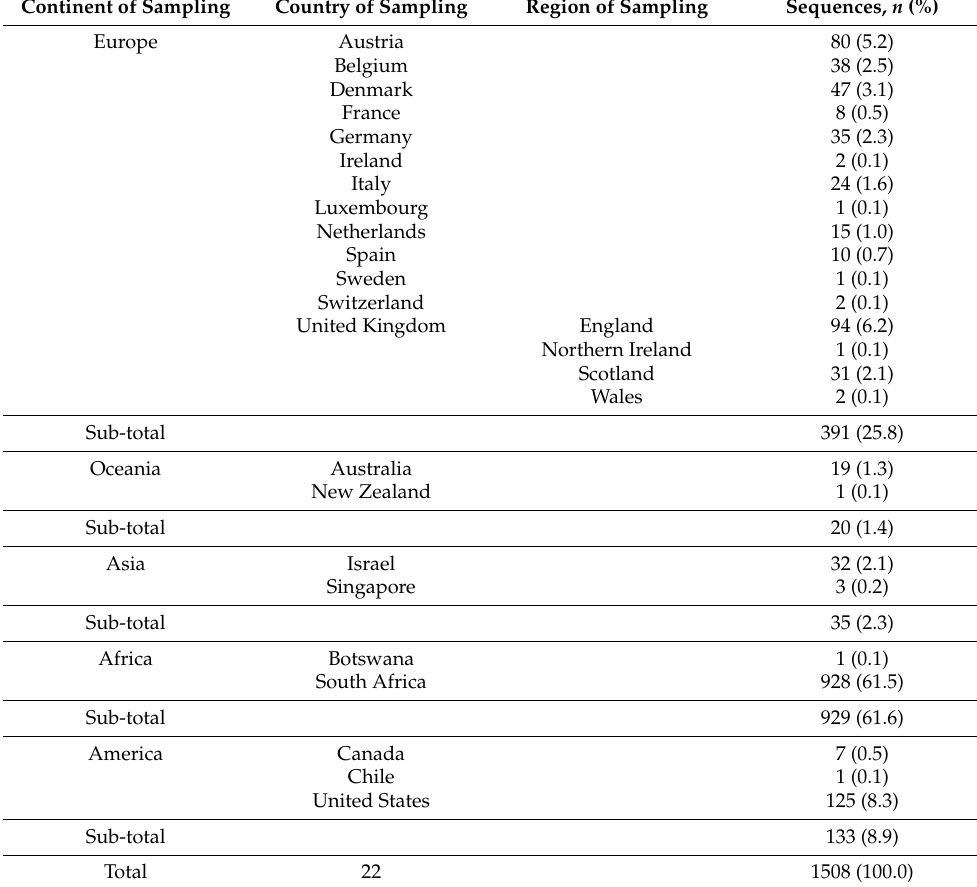
Table 1. Total number of SARS-CoV-2 BA.4 sequences from GISAID database sampled until 10 May 2022, categorized by continent, country, and region of sampling. Sequences of low quality were